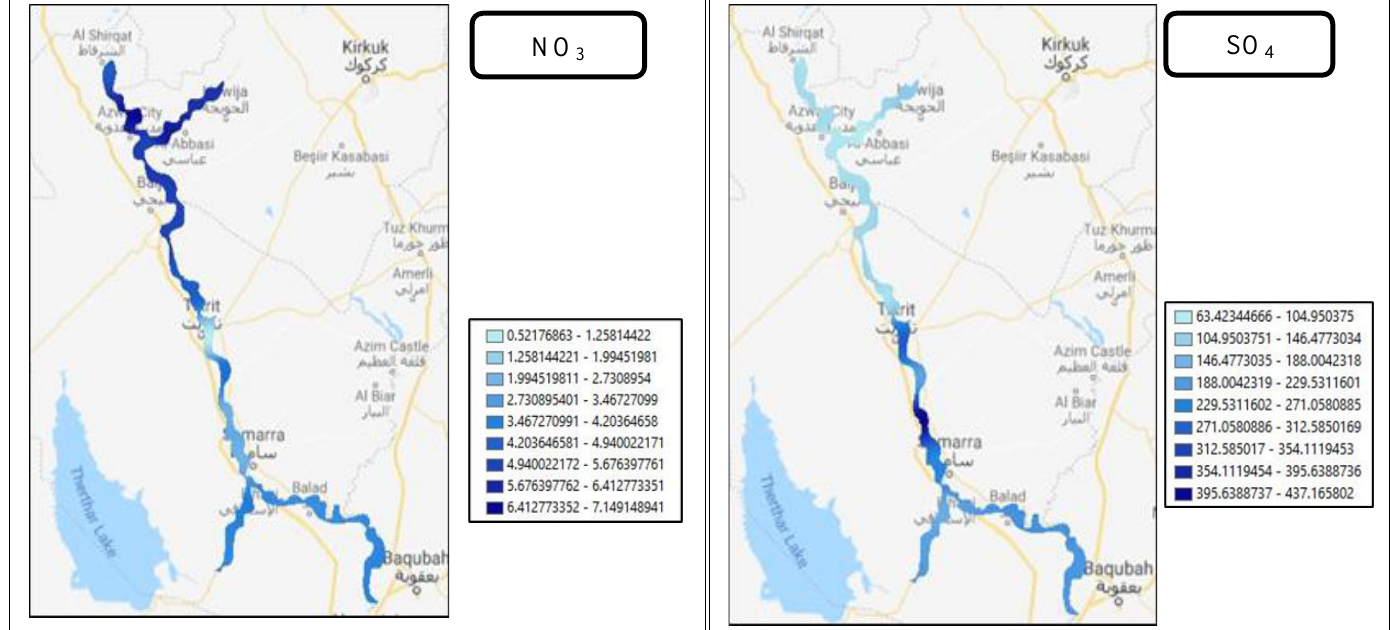
Fig.6: Spatial maps of concentration distribution for (I) NO